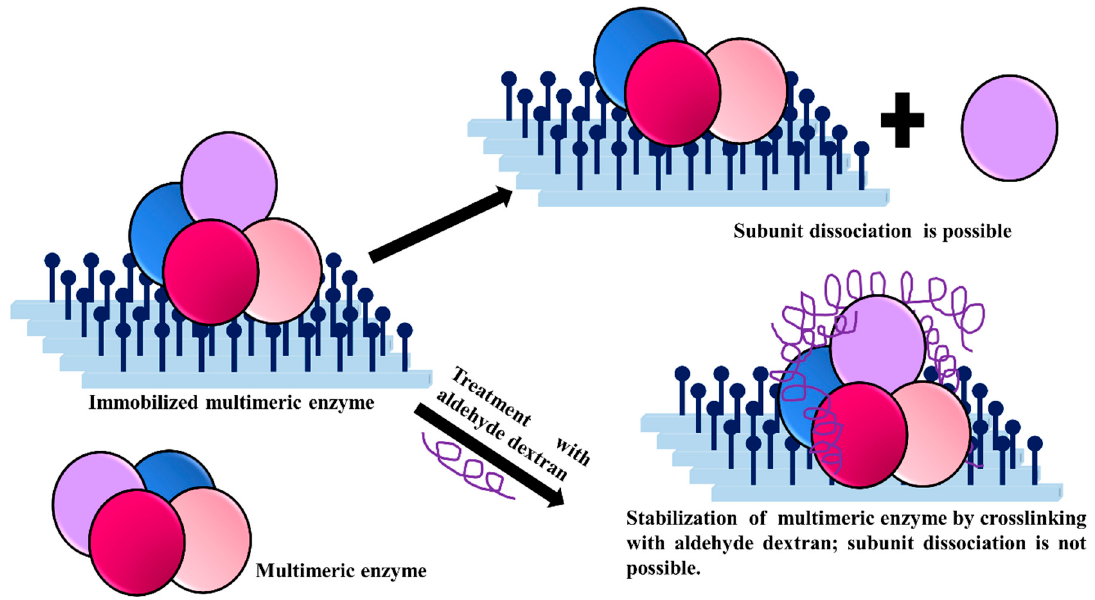
Figure 18. Stabilization of immobilized multimeric enzymes by intersubunit crosslinking using dexOx if some enzyme subunits remain no attached to the support.